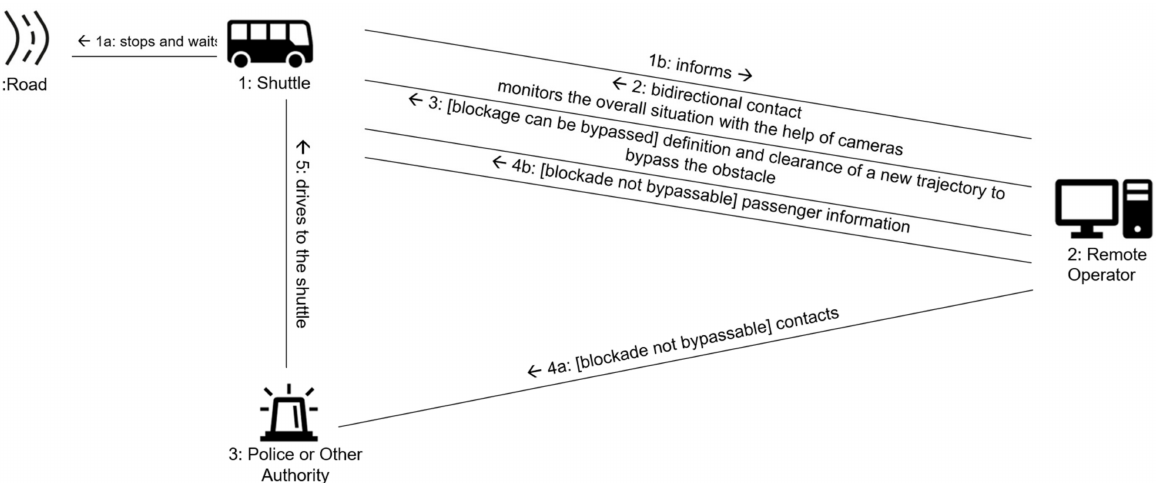
Figure 6. Interaction diagram for the scenario with the cause “Vehicles parked in second row”. The lane is blocked, e.g., due to vehicles parked in second row. This causes delays or disturbs the onward journey of the shuttle. The shuttle waits due to the blocked lane (1a). The shuttle informs the remote operator that no further travel is possible due to an obstacle (1b). The remote operator is in bidirectional contact with the passengers and switches to the shuttle’s cameras to get an overall view (2). The remote operator finds out whether it is possible to bypass the obstacle. The remote operator sets a new trajectory, e.g., by setting waypoints, selecting a trajectory, or steers the AV manually around the obstacle, gives clearance, and permits the AV to continue (3). If this is the case, the shuttle can continue its journey. If a bypass cannot take place due to e.g., constructional conditions, then the remote operator contacts the police or another authority (4a). The passengers are proactively informed about the further procedure and possible delays (4b). The police or another authority drive to the shuttle and solve the blockade